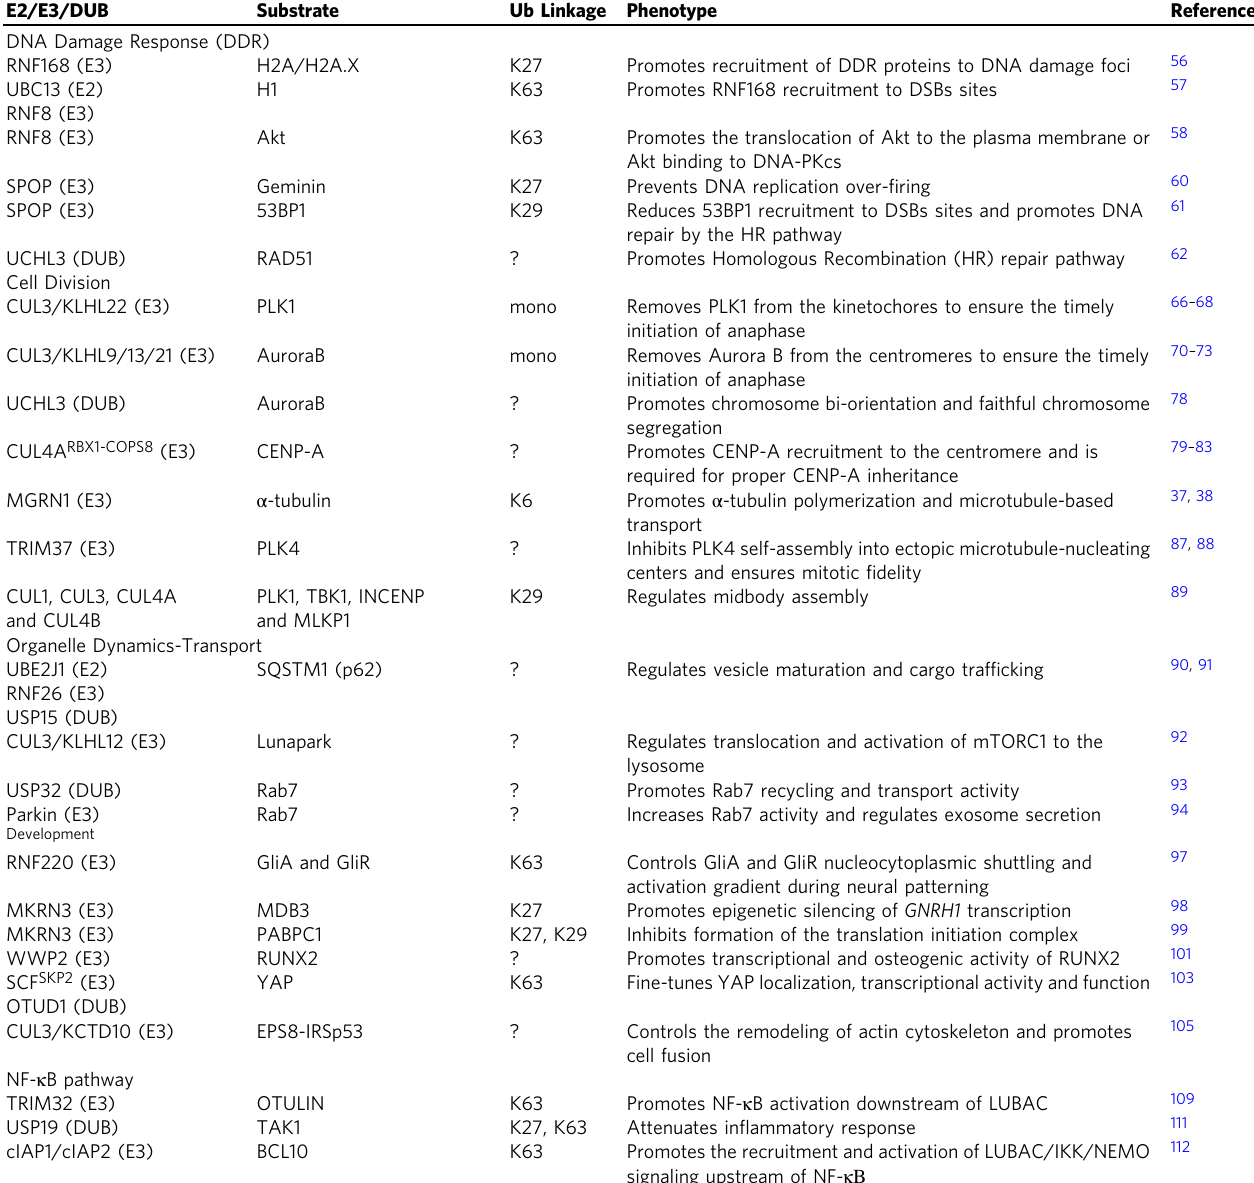
Table 1 List of non-proteolytic ubiquitylation events described in different cellular signaling